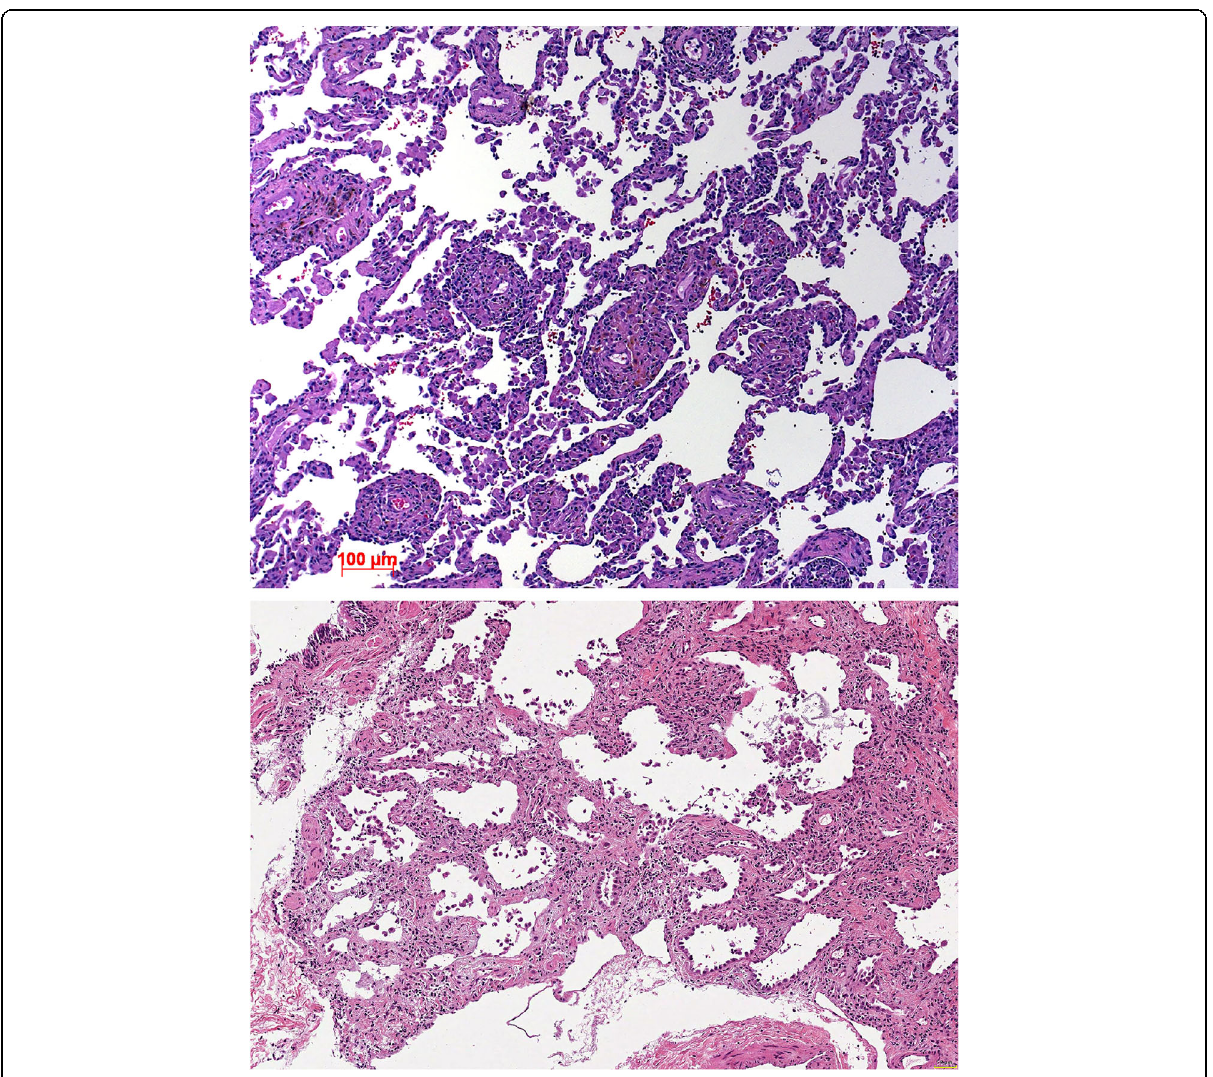
Fig. 20 NSIP, cellular upper, fibrotic lower panel; note the mixed infiltration by lymphocytes, plasma cells and histiocytes. H&E, bars 100 and 50 μ